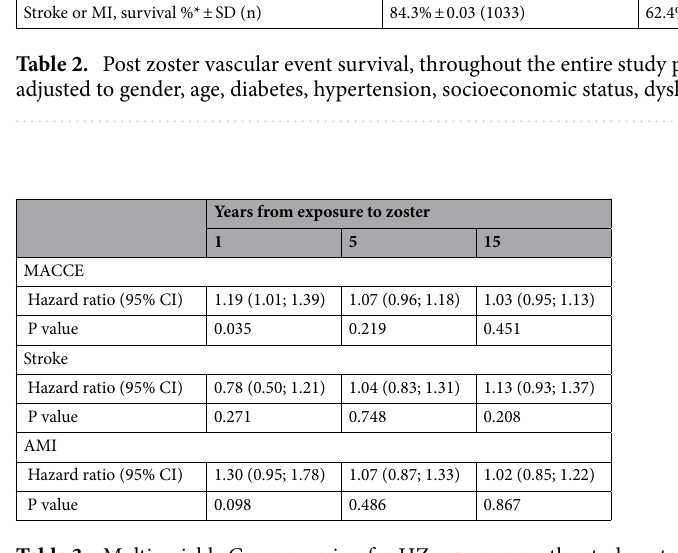
Table 3. Multivariable Cox regression for HZ exposure on the study